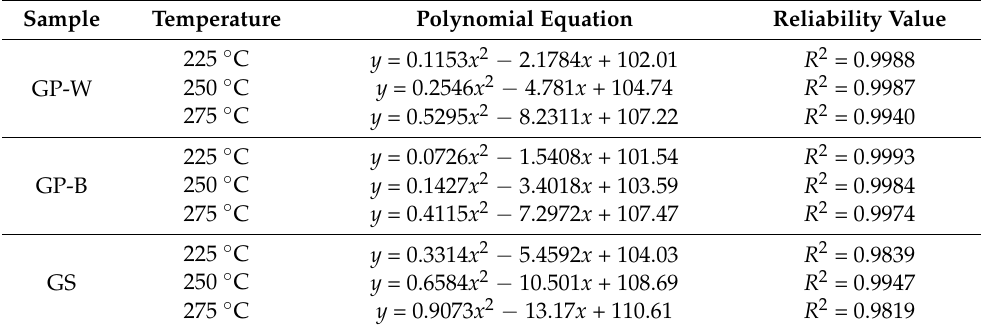
Table 2. Regression statistical analysis of mass recovery results.